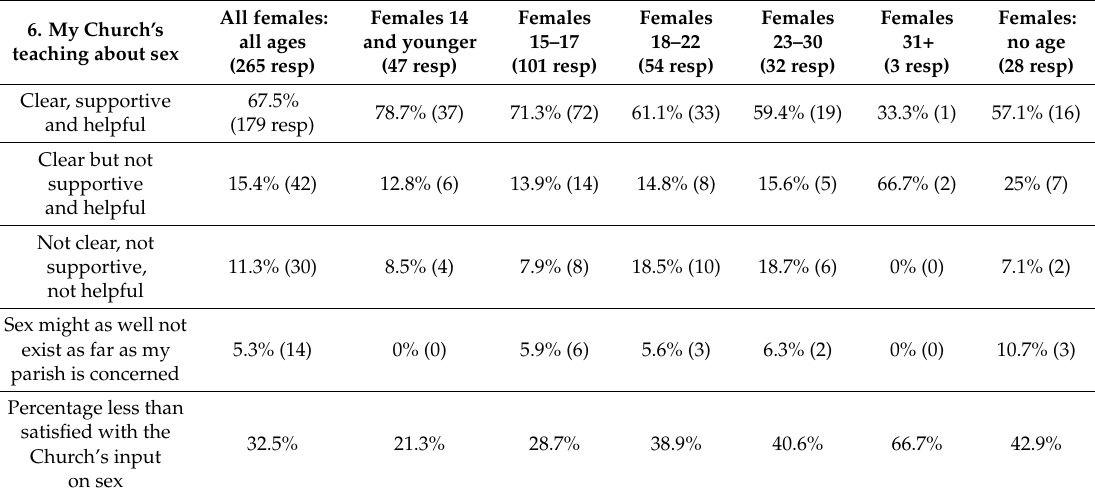
Table 8. Church’s Teaching about Sex—All